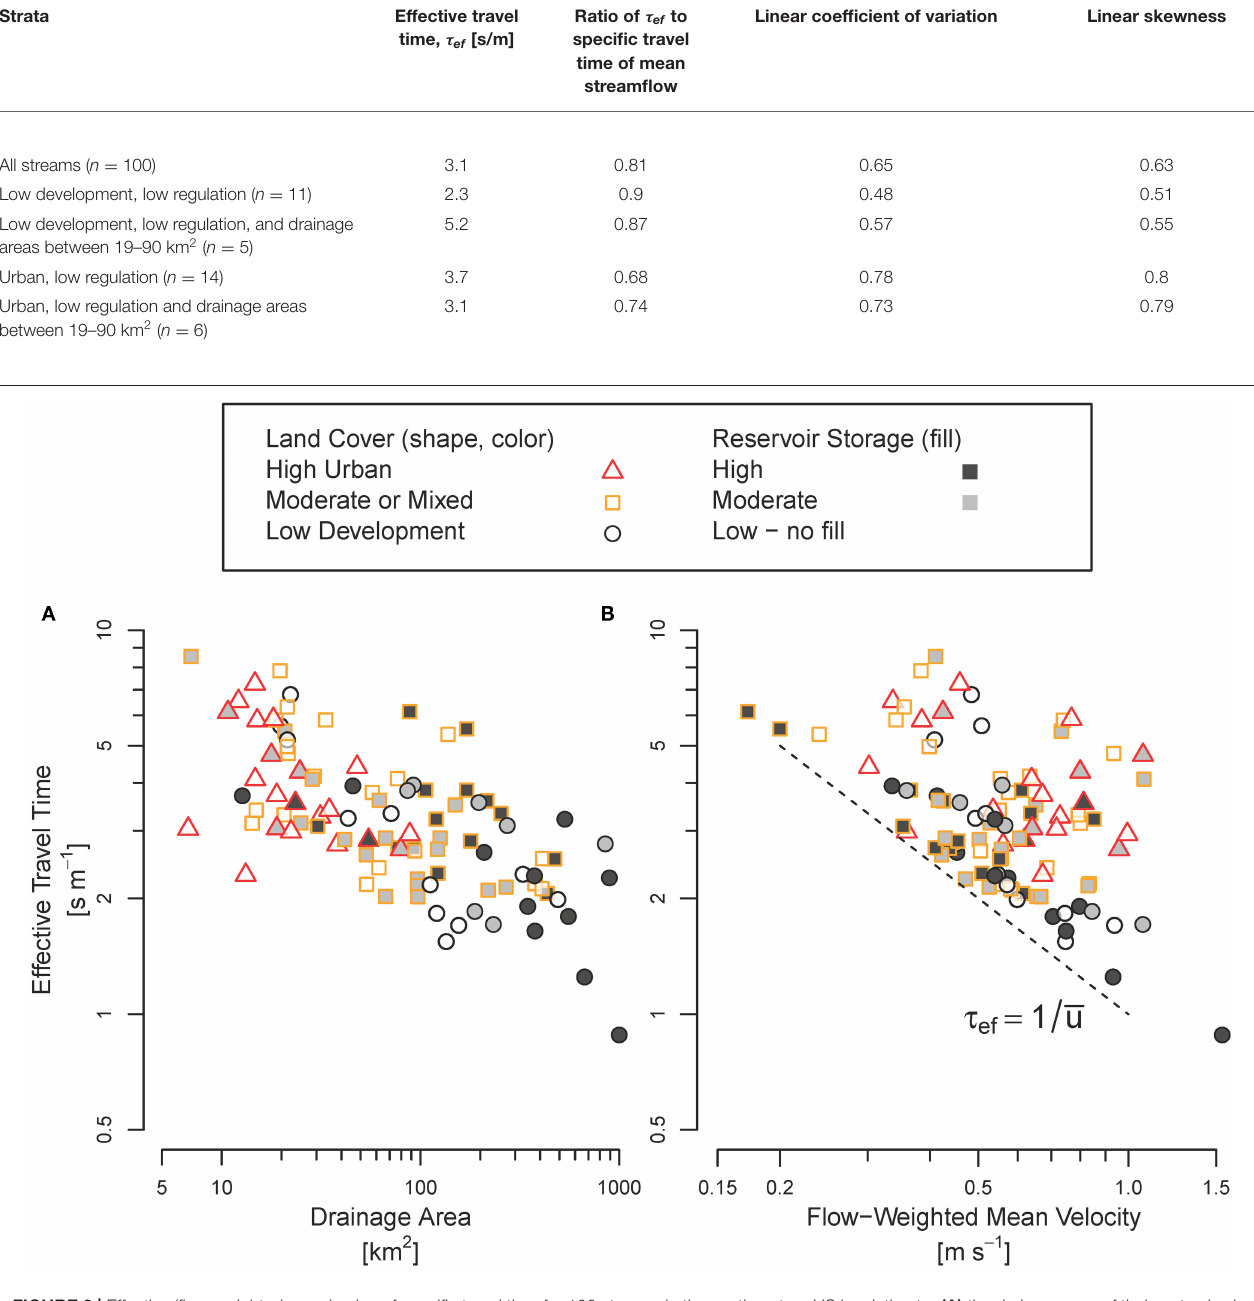
FIGURE 3 | Effective (flow-weighted mean) value of specific travel time for 100 streams in the southeastern US in relation to: (A) the drainage area of their watersheds; and (B) flow-weighted mean velocity, with a dashed line indicating where travel time would be equal to the inverse of flow-weighted mean